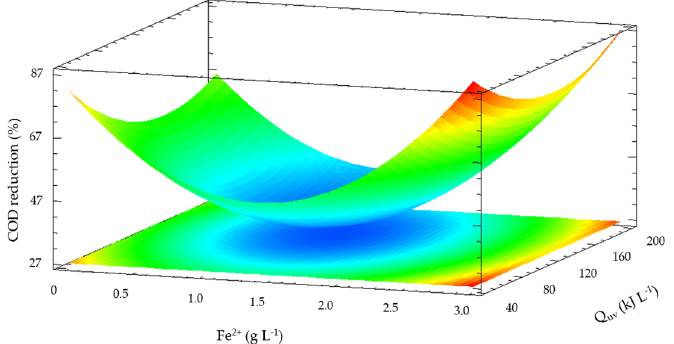
Figure 5. Response surface plot for interactive effect of Fe 2+ dose and accumulate UV energy on COD reduction for solar photo-Fenton experiments in pre-treated leachate with PAC coagulant. H 2 O 2 dose = 14.68 g L − 1 .